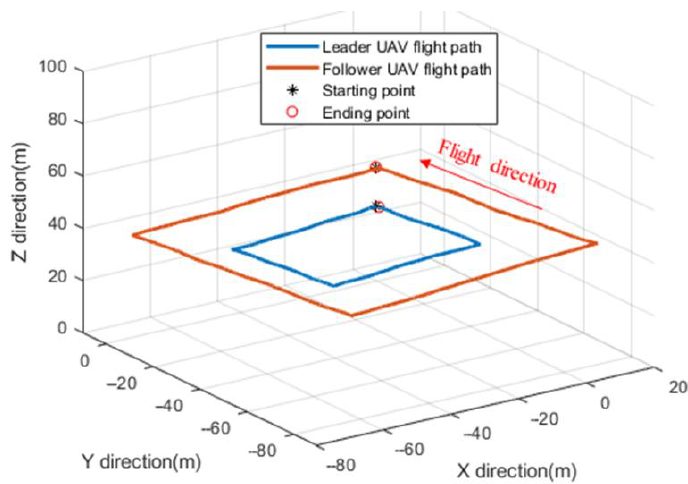
Figure 7. The flight path of leader and follower UAV.